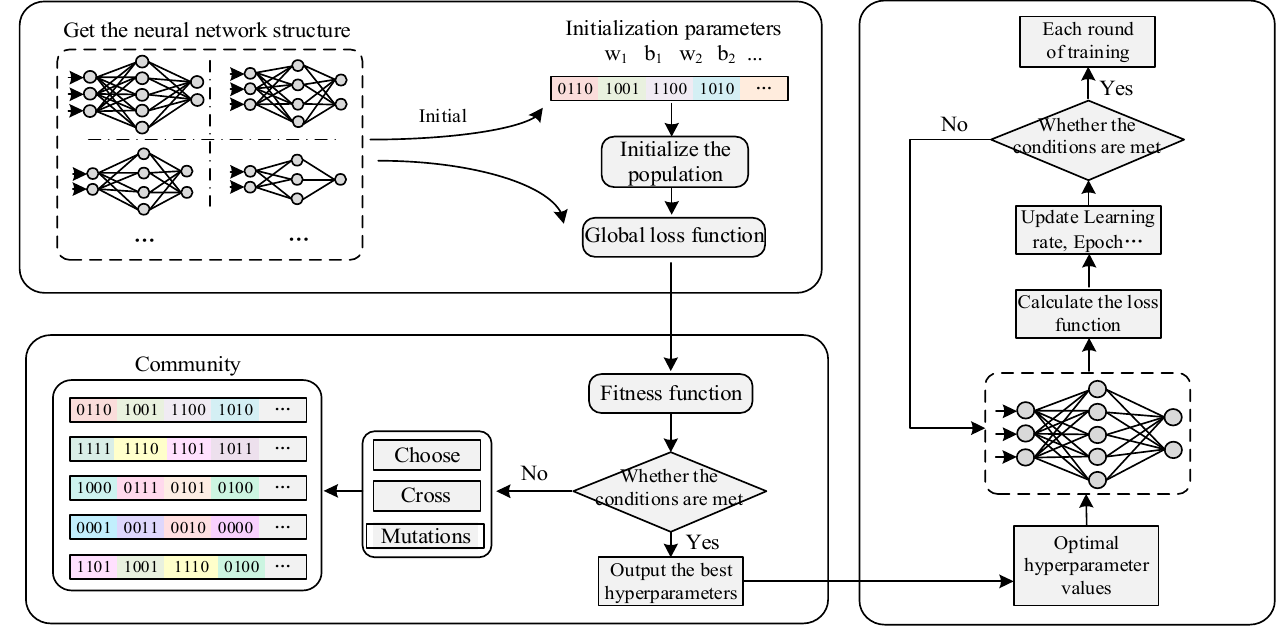
Figure 2. The proposed improved genetic neural network. structure of the neural network according to the actual problem. For example, when per- forming a multi-classification task, the number of output nodes must be the same as the type of classification. Second, initialize the population and encode the hyperparameters (learning rate, number of iterations, number of training rounds, number of hidden layer units, number of hidden layer layers) for each individual of the population [31,32]. Third, calculate the fitness value of each individual through the loss function and fitness func- tion, and sort them according to the size of the fitness value, and select the optimal top 5% and the top 95%. Fourth, the individuals of the newly built community are randomly matched into pairs, each individual is crossed according to a certain crossover rate, and each individual in the population is subjected to mutation operation with a probability of 0.1. Fifth, the fitness of individuals in the new population is calculated. If the termination condition is met, the update of the community is stopped, otherwise, re-selection, crosso- ver and mutation operations are performed. Sixth, select the optimal fitness and complete